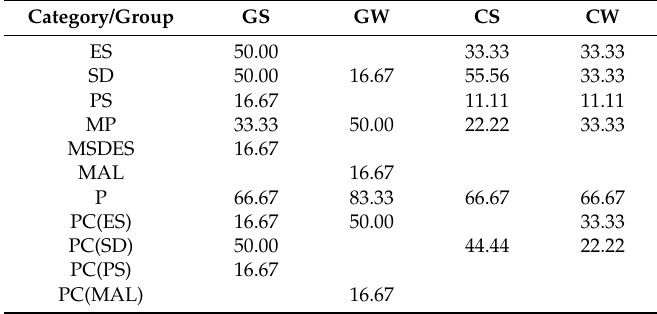
Table A2. Percentages of groups that formulate an aspiration level according to the respective category at least